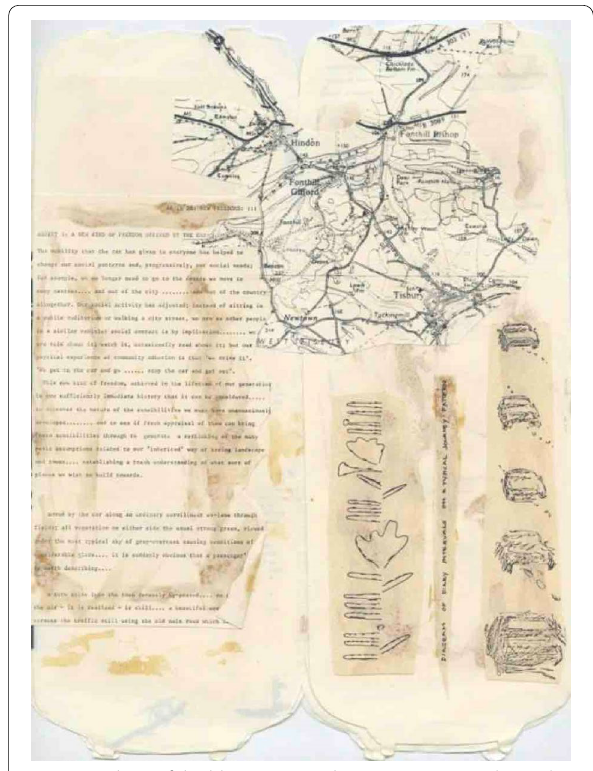
Fig. 3 Mock-up of double page spread AS in DS: an eye on the road . Artwork by Smithson (1982). Credits: Smithson Family